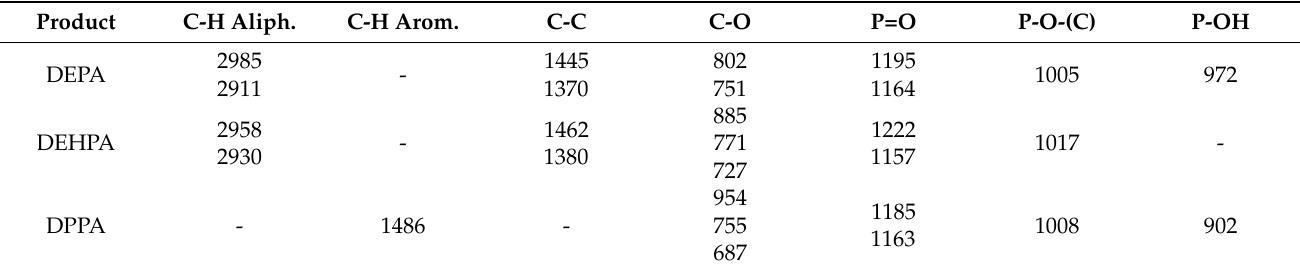
Table 2. Characteristic bands of ATR-FT/IR spectra of phosphates [cm − 1 ].